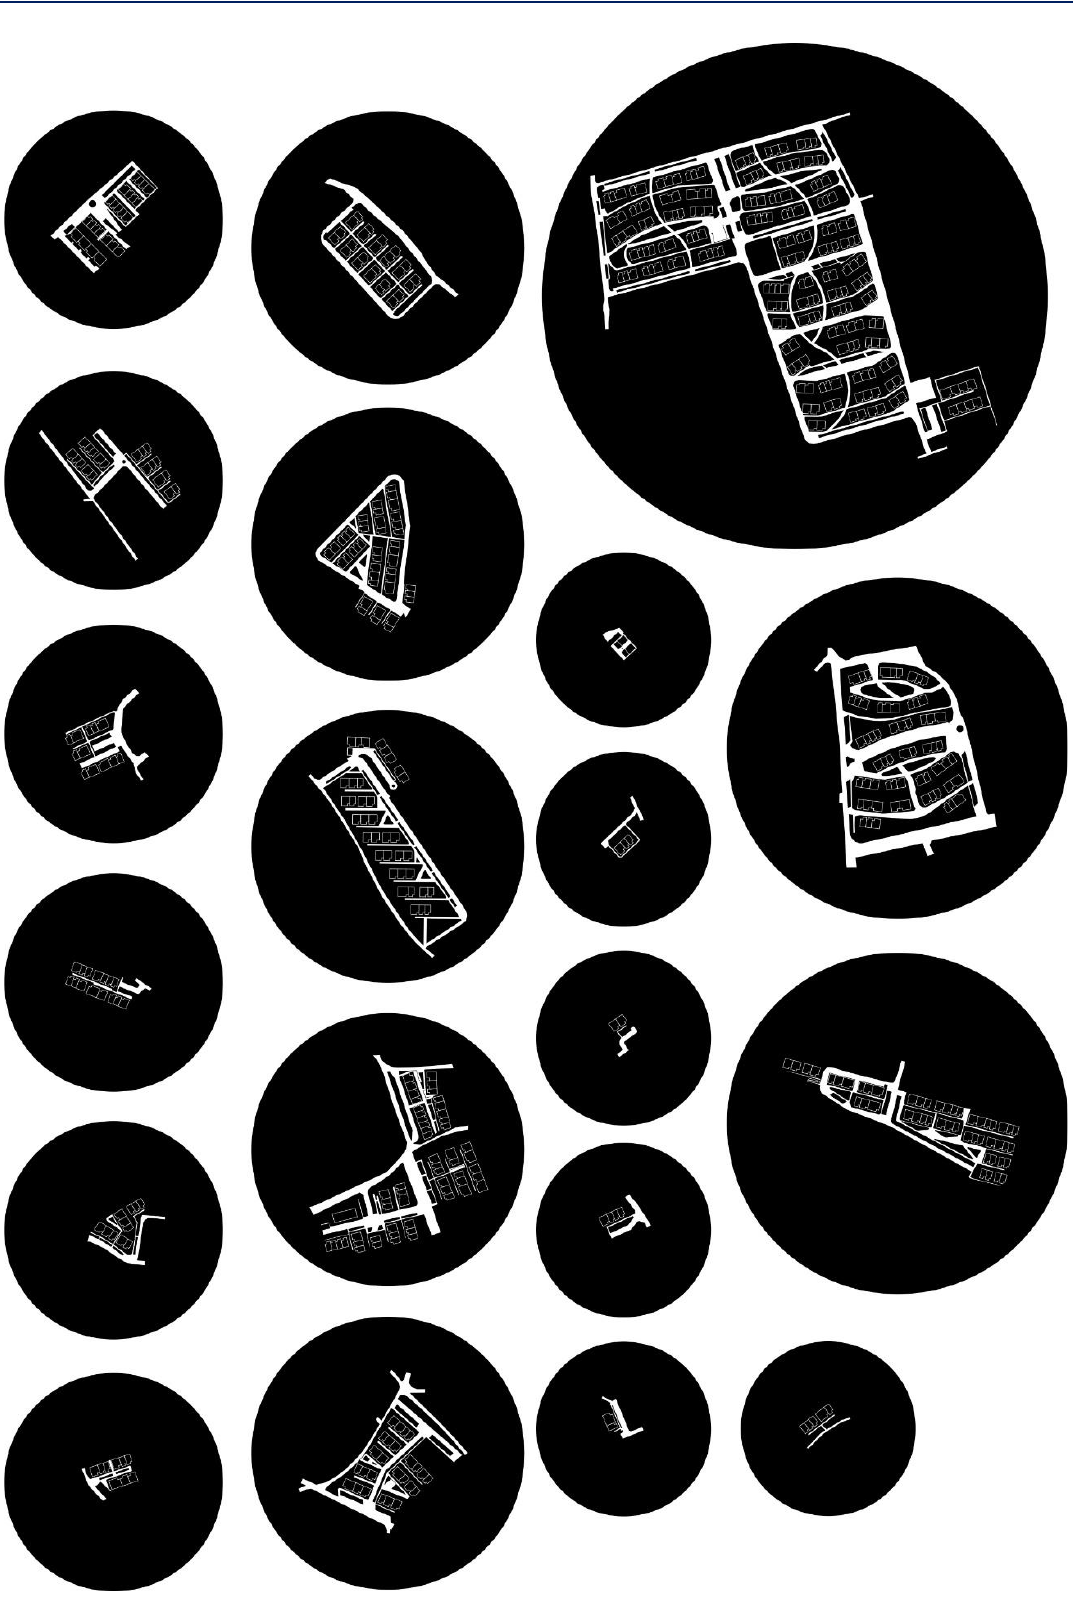
Figure 2 Norcia 20 TH sites layouts. The space considered in the spatial permeability analysis is represented in